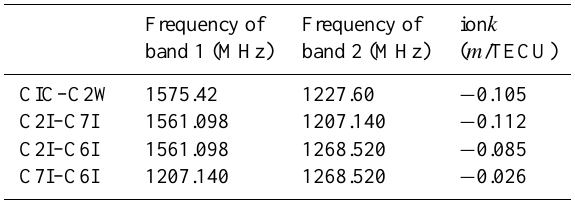
Table 1. Carrier frequencies and ion k of DCB in different carrier pairs.